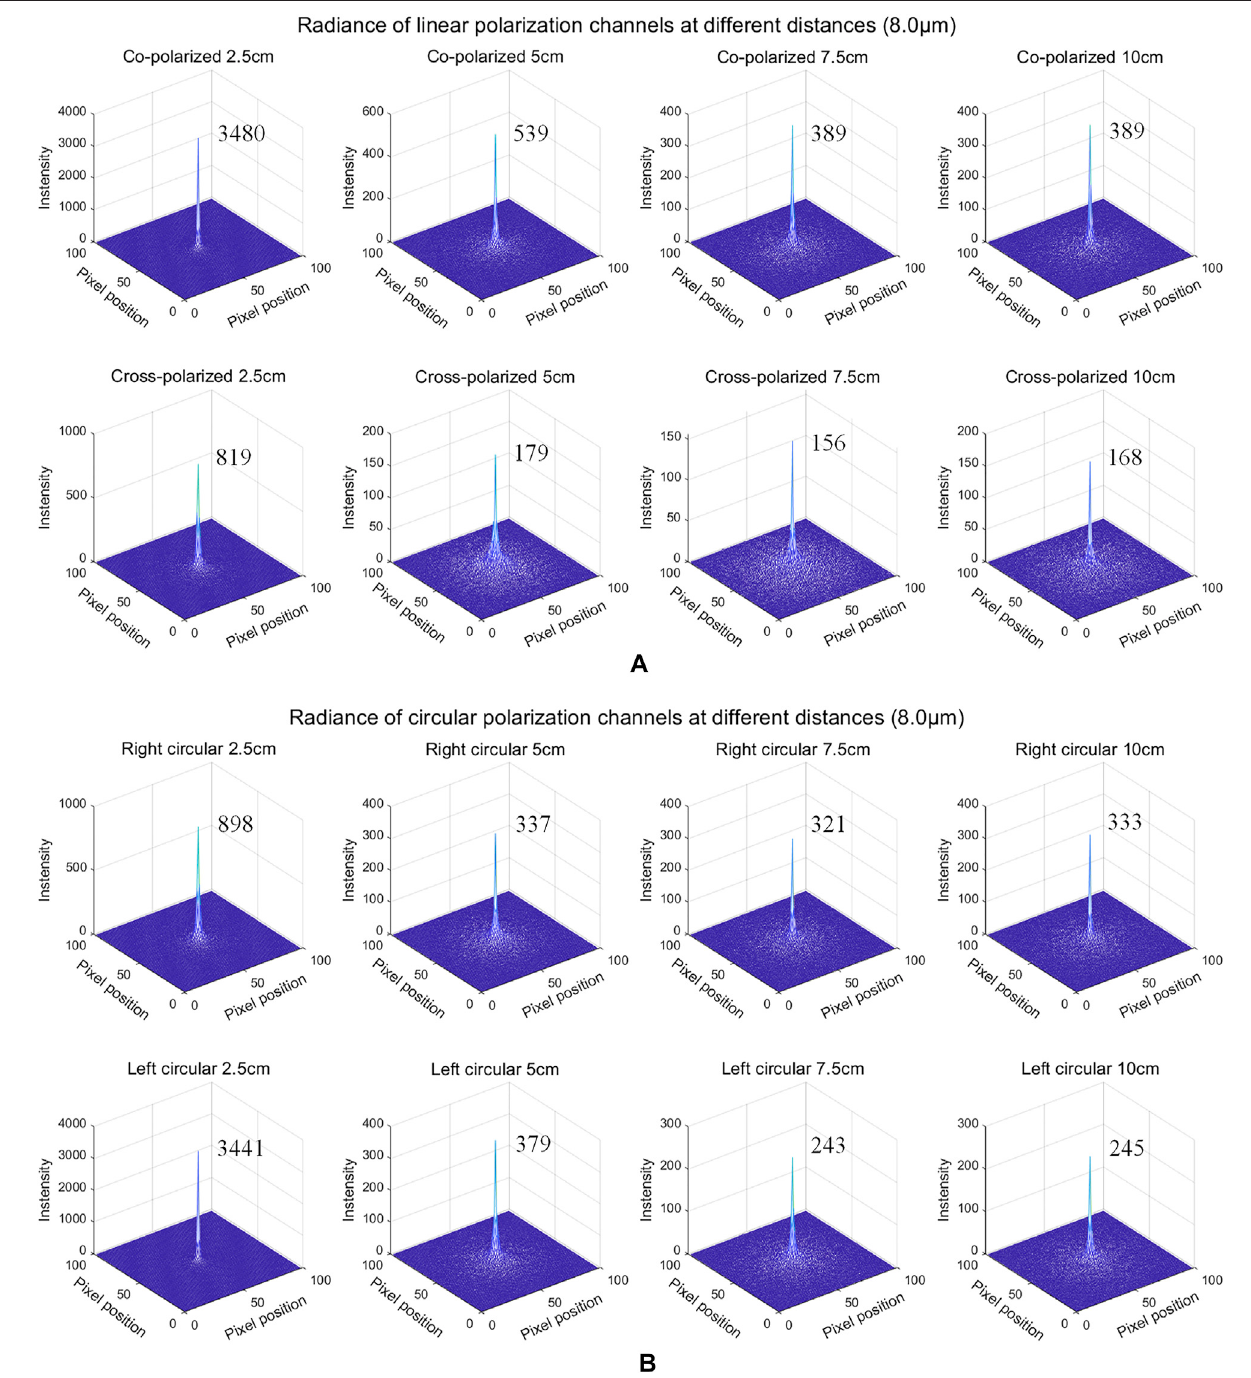
FIGURE 7 | Radiance of polarization channels at different distances in the medium with large-sized particles (8.0 μ m) (A) co-polarized and cross-polarized radiance, (B) right circular and left circular polarized radiance at 2.5 cm, 5 cm, 7.5 cm, 10 cm, respectively.